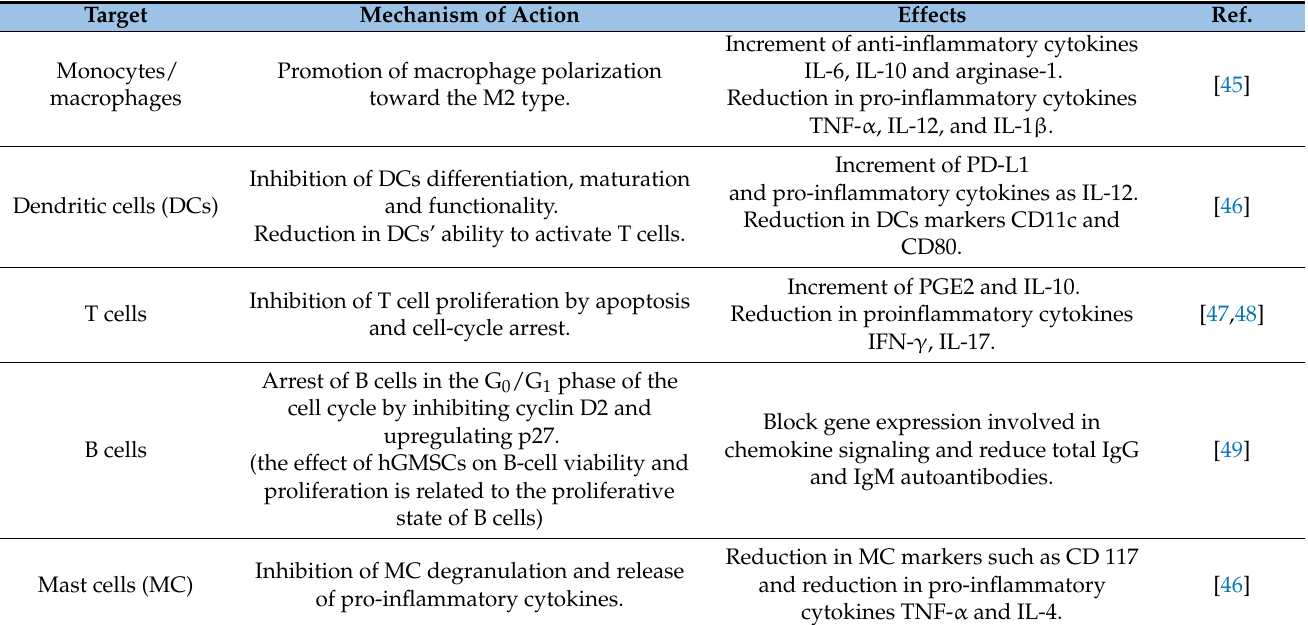
Table 3. Immunomodulatory properties of